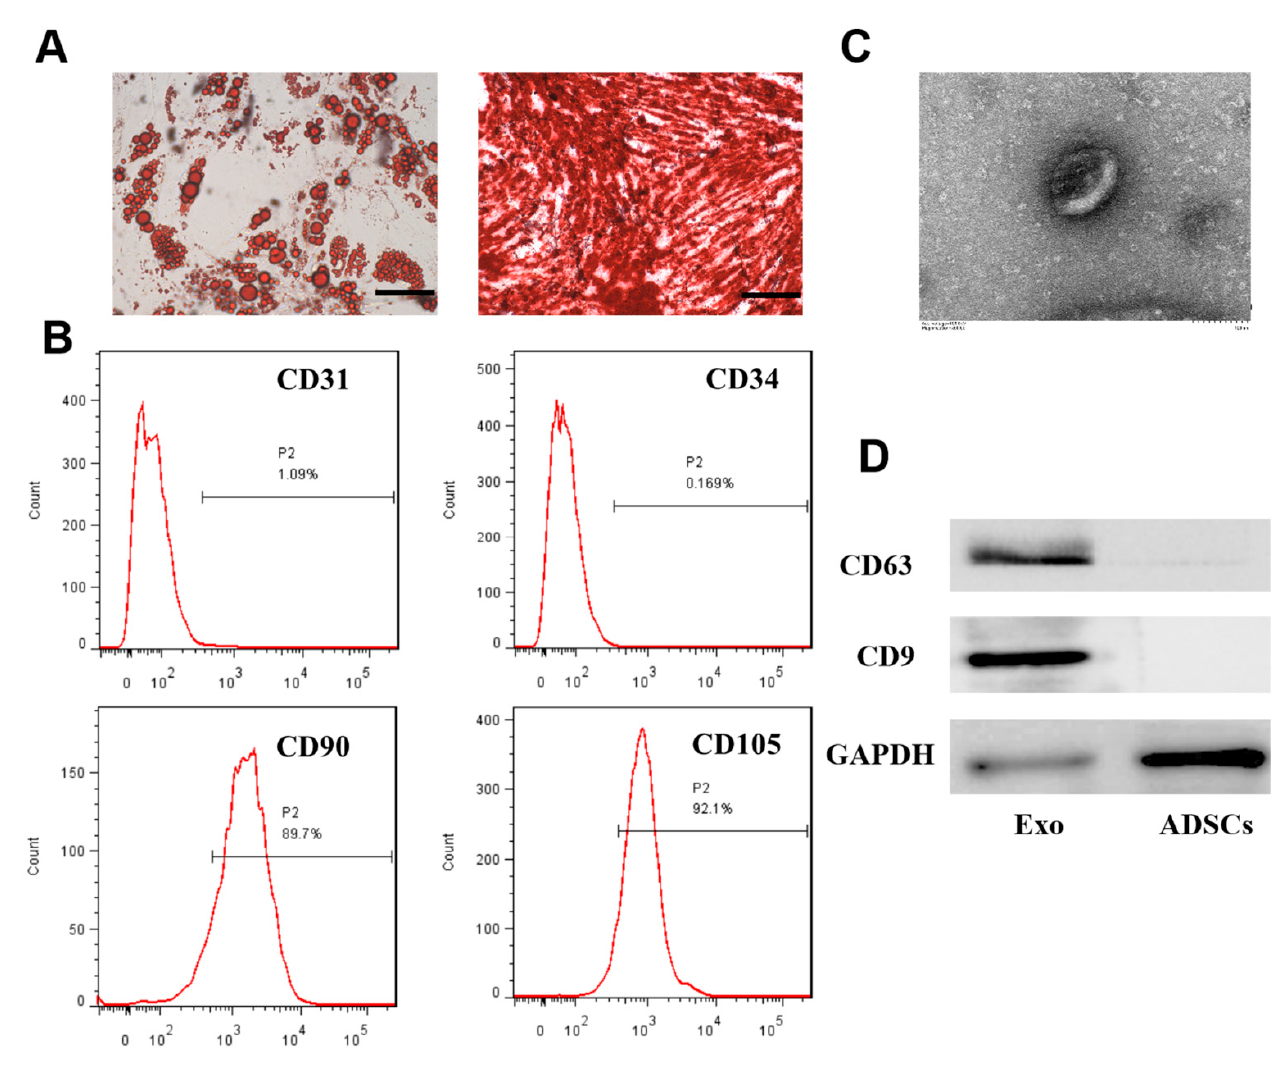
Figure 1. The identification of ADSCs and ADSCs-exos. ( A ) Adipogenic and osteogenic differentia- tion was examined by Oil Red O staining and Alizarin Red S staining (scale = 50 μ m). ( B ) Analysis of ADSCs by flow cytometry. The results showed negative expression of CD31 and CD34 (1.09% and 0.169%, respectively) and positive expression of CD90 and CD105 (89.7% and 92.1%, respectively). ( C ) Analysis of ADSC-exos morphology by TEM (scale = 100 nm). ( D ) Western blot analysis of exosome markers (CD63 and CD9).